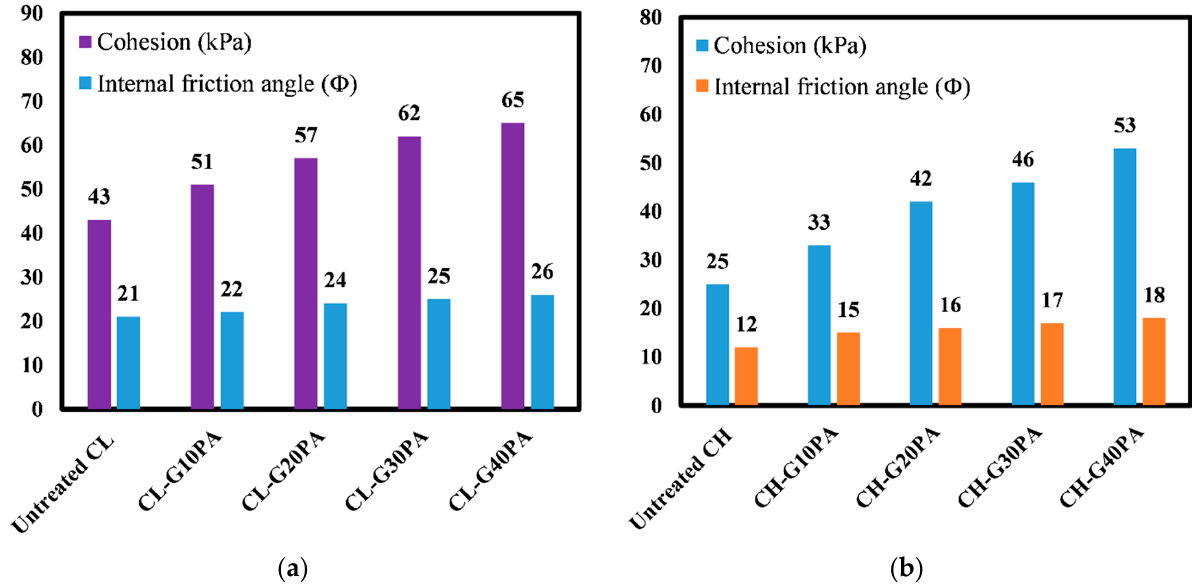
Figure 6. Parameters of shear strength for soils treated with G10PA, G20PA, G30PA and G40PA: ( a ) CL, ( b ) CH.